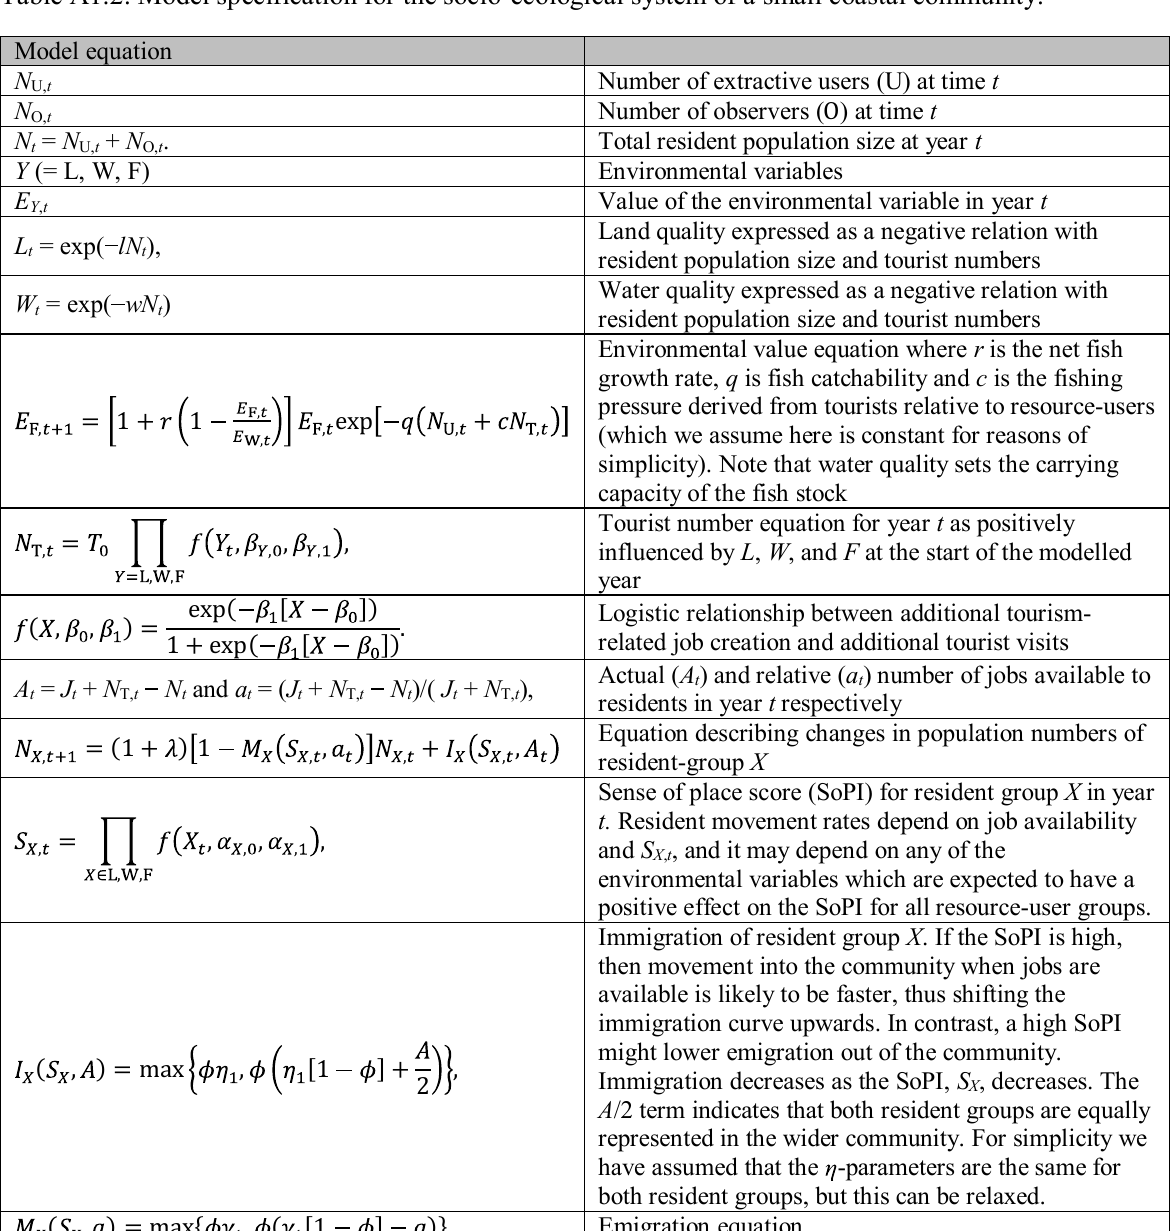
Number of extractive users (U) at time